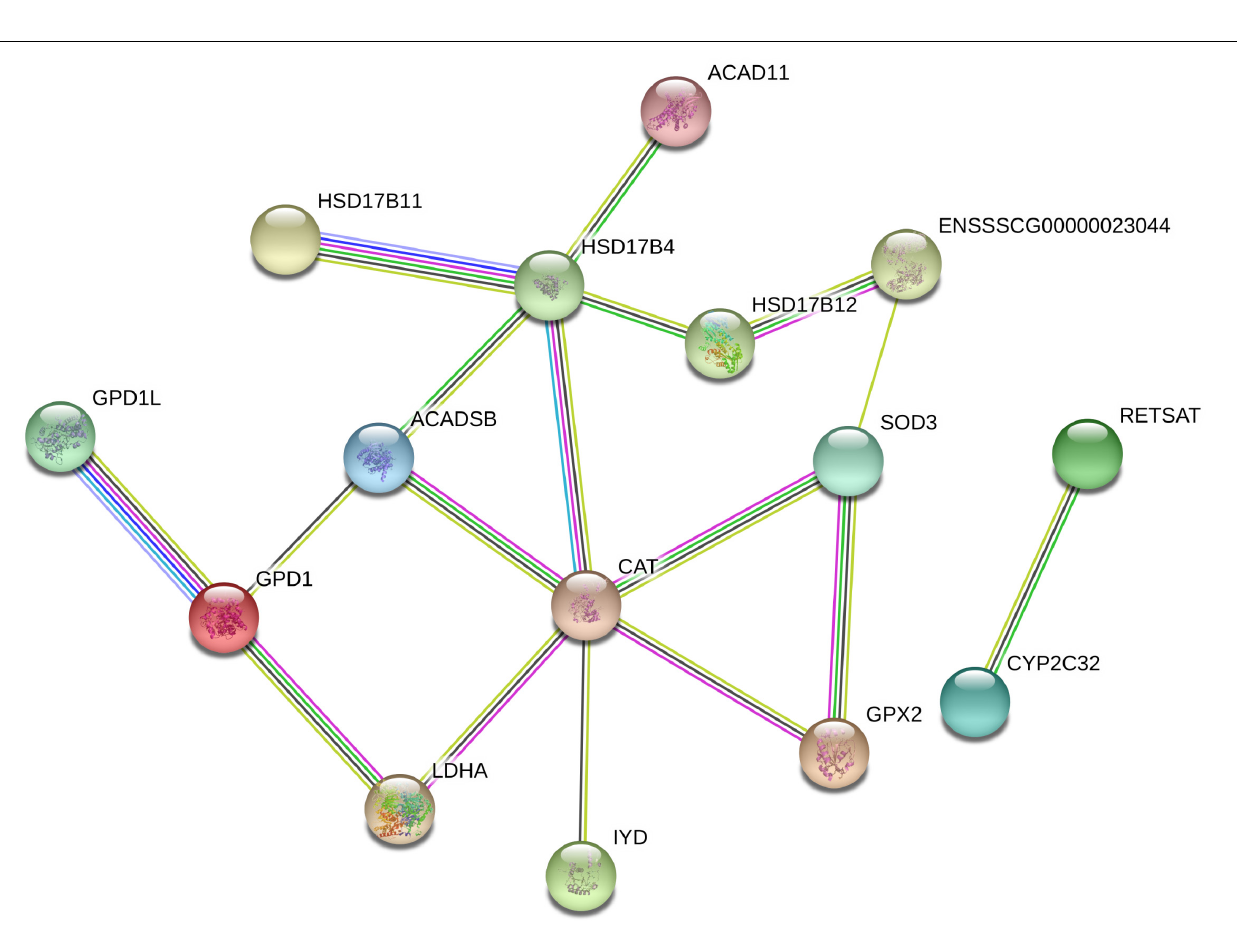
FIGURE 5 | Interaction networks of proteins encoded by DEGs related to oxidative stress. Line colors represent different evidentiary sources for each interaction: light blue, from curated databases; purple, experimental; green, gene neighborhood; red, fusion; blue, gene cooccurrence; yellow, text mining; black, coexpression; light purple, protein homology. Disconnected nodes are not shown in the